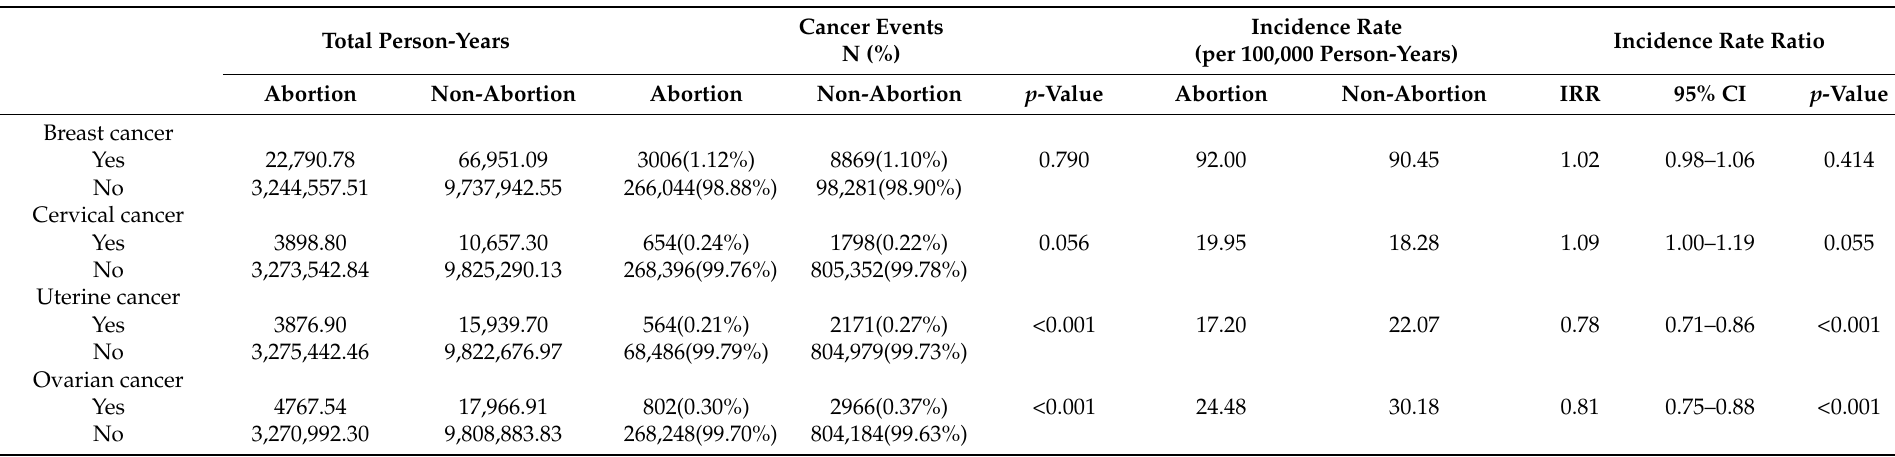
Table 2. Comparisons of cancer incidence rates, incidence rate ratios, and hazard ratios for female cancers between matched abortion and non-abortion cohorts. Cancer Events Incidence Rate Total Person-Years Incidence Rate Ratio N (%) (per 100,000 Person-Years) Abortion Non-Abortion Abortion Non-Abortion p -Value Abortion Non-Abortion IRR 95% CI p -Value Breast cancer